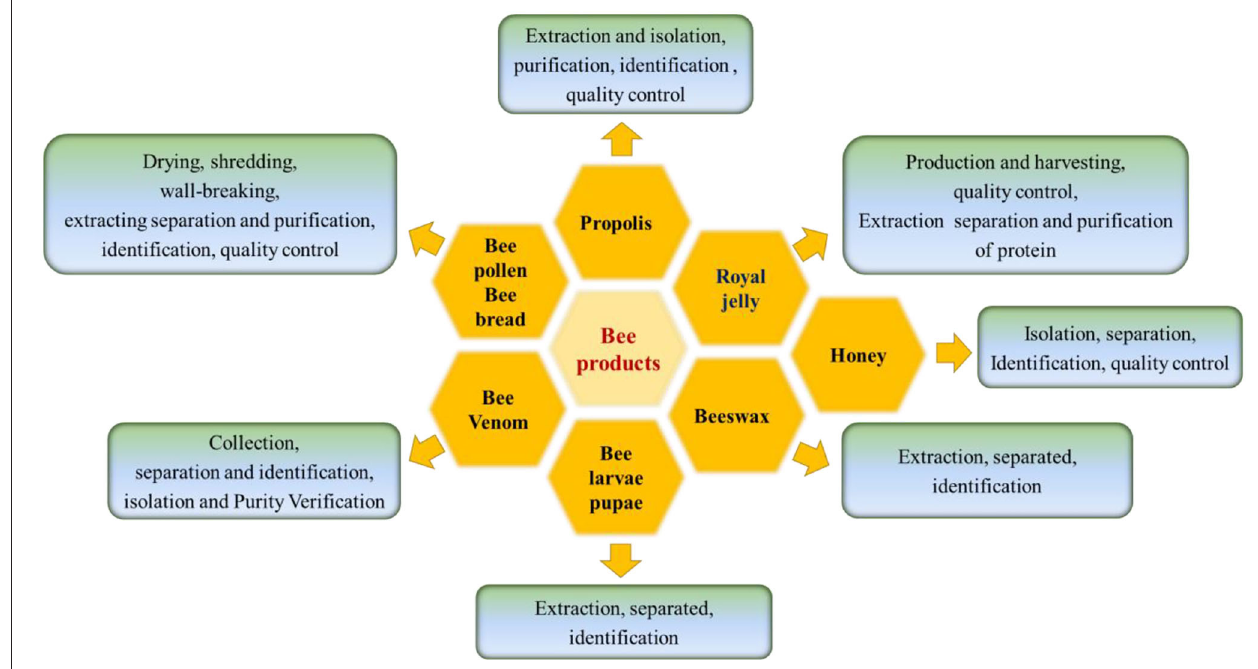
FIGURE 3 | Processing techniques used for bee